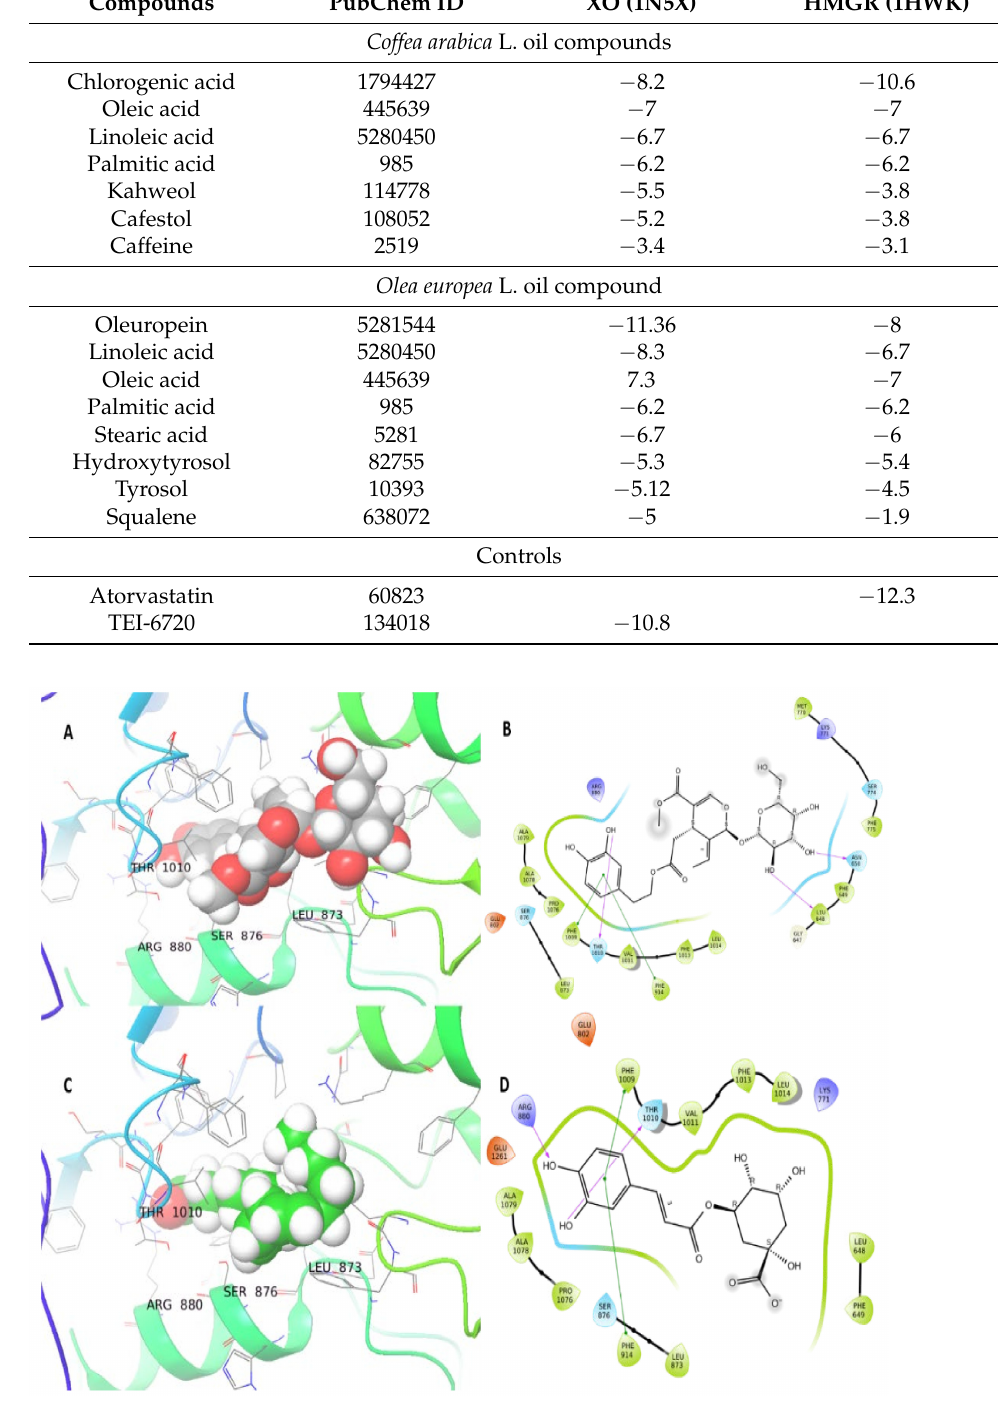
Figure 6. 3D and 2D interaction of XO protein, the ligands are shown in balls at 3D representation, and the protein backbones are shown in ribbons, hydrogen bonds are shown in purple arrows, bi-bi stacking is shown in green lines. ( A , B ): Three-dimensional and two-dimensional interface of oleuropein. ( C , D ): Three-dimensional and two-dimensional interface of XO protein and chlorogenic acid